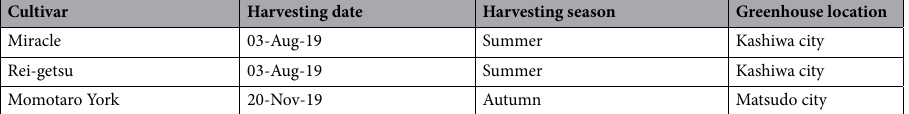
Table 3. Information on cultivars, harvesting date, harvesting season, and greenhouses location of tomato samples.